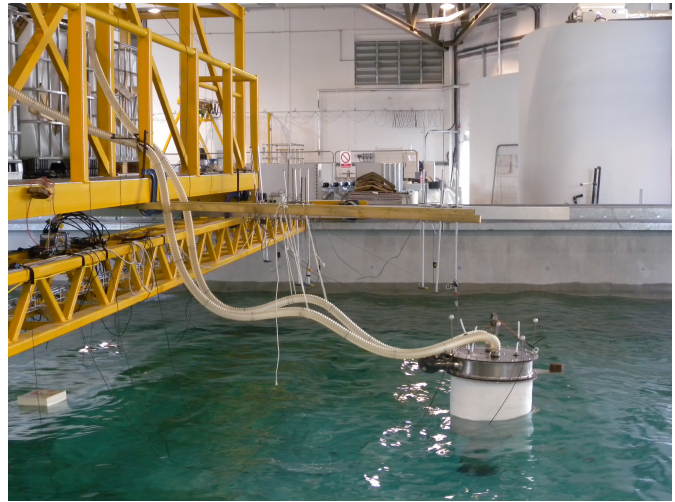
Figure 3. Physical model of the Tupperwave